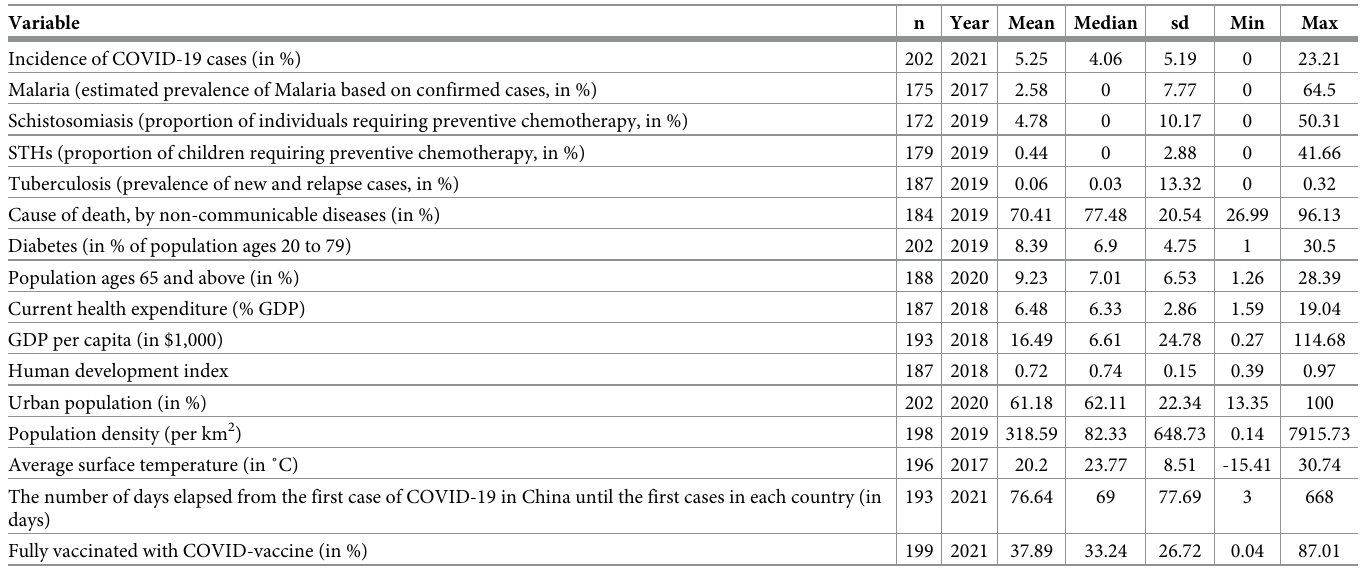
Table 2. Summary statistics of the variables included in the